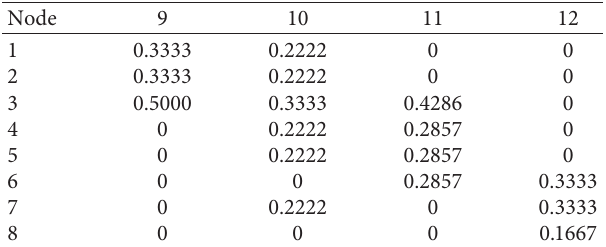
Figure 7: Supply chain network. Table 4: Quality risk propagation coefficient matrix of the first- level to second-level nodes.